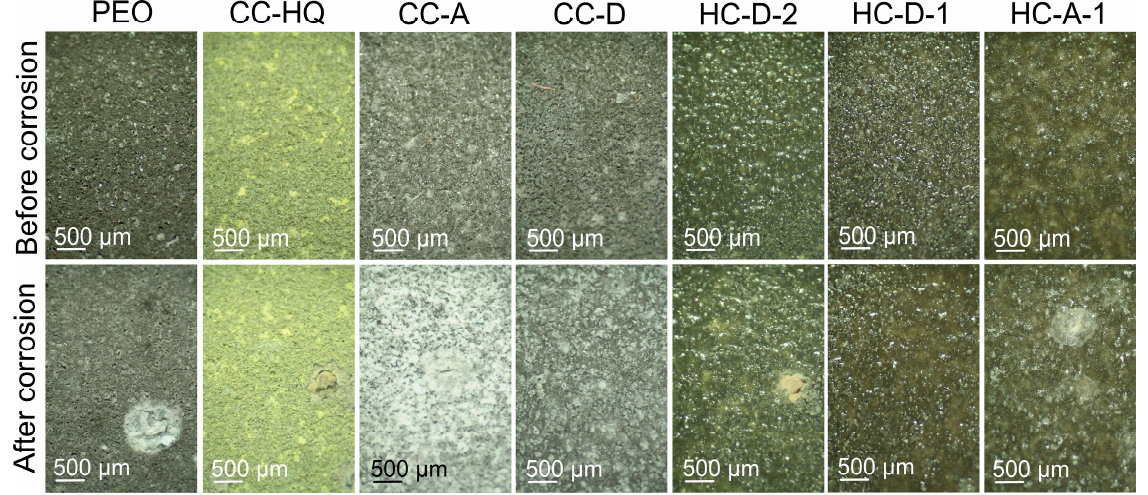
Figure 12. The photographs of the samples before and after 7 days of immersion in 3.5 wt.% NaCl solution.